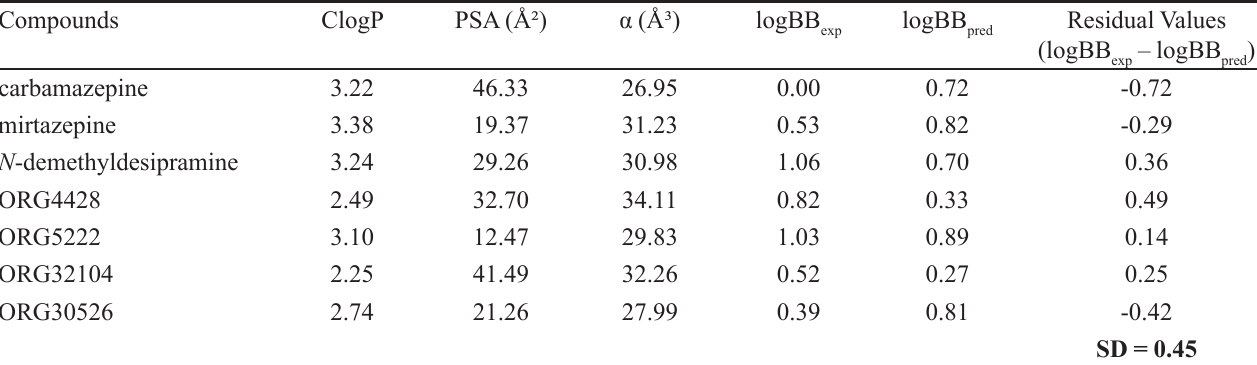
TABLE VI - Molecular descriptors of the best QSPR model (model 4), the experimental and calculated logBB values, the residual values and the respective SD value found for the test set compounds